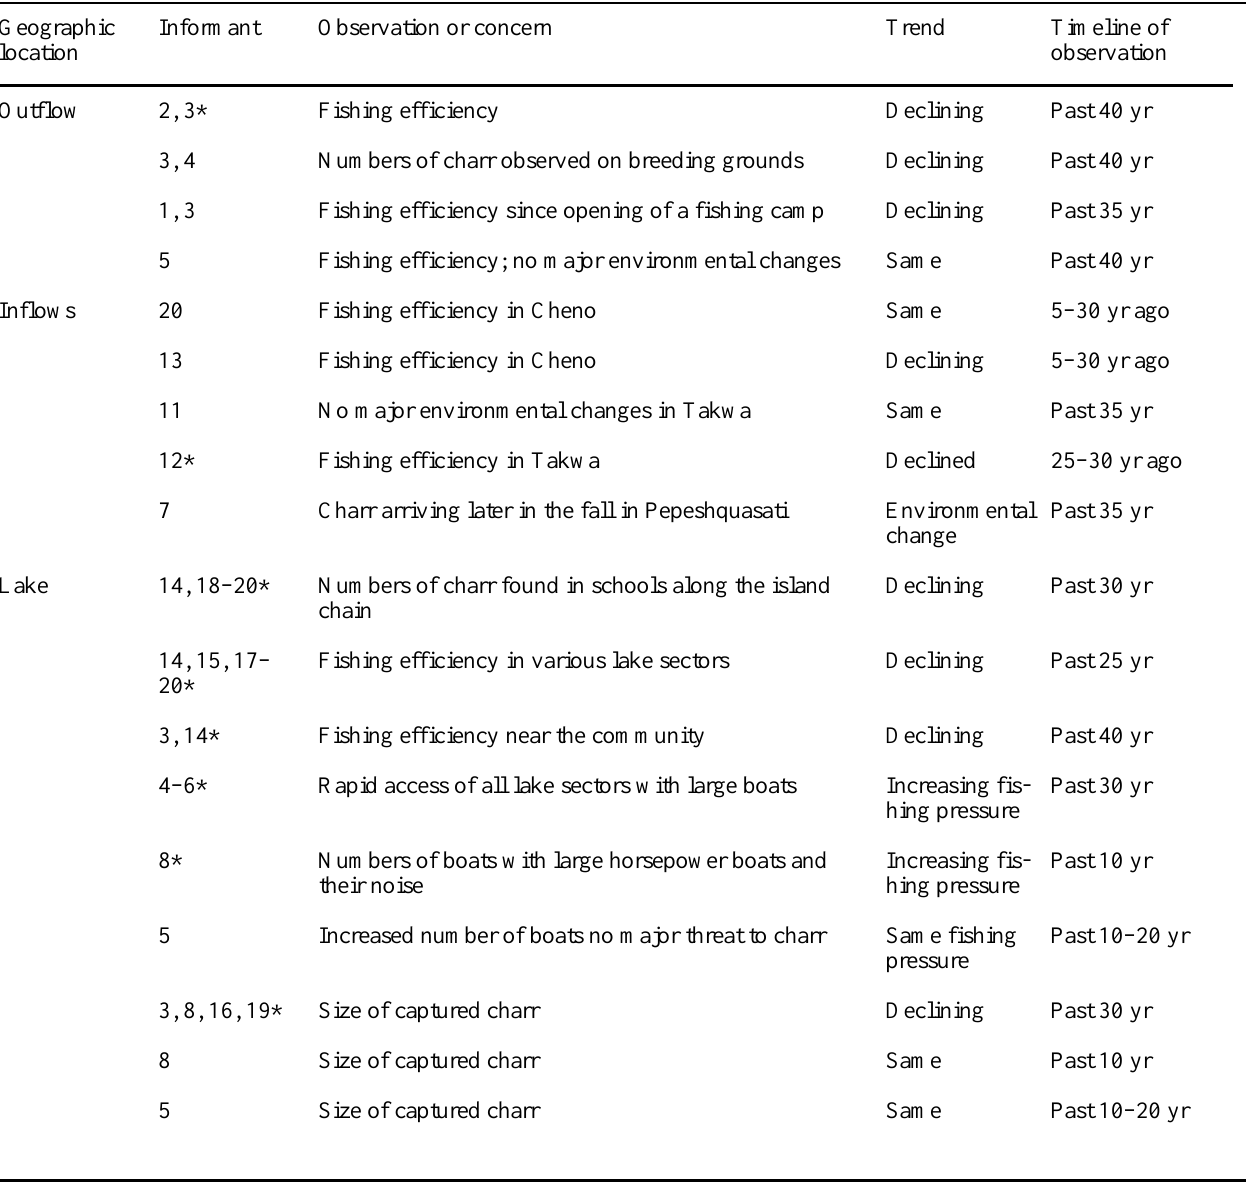
Table 5. Aboriginal concerns relating to human pressures on brook charr in Mistassini Lake, according to local experts. Asterisks denote where community fishers and/or fishing guides made similar